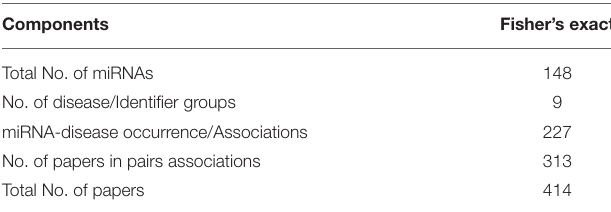
TABLE 1 | Summary of the number of miRNAs, diseases/identifiers, miRNA-disease associations, and number of papers.